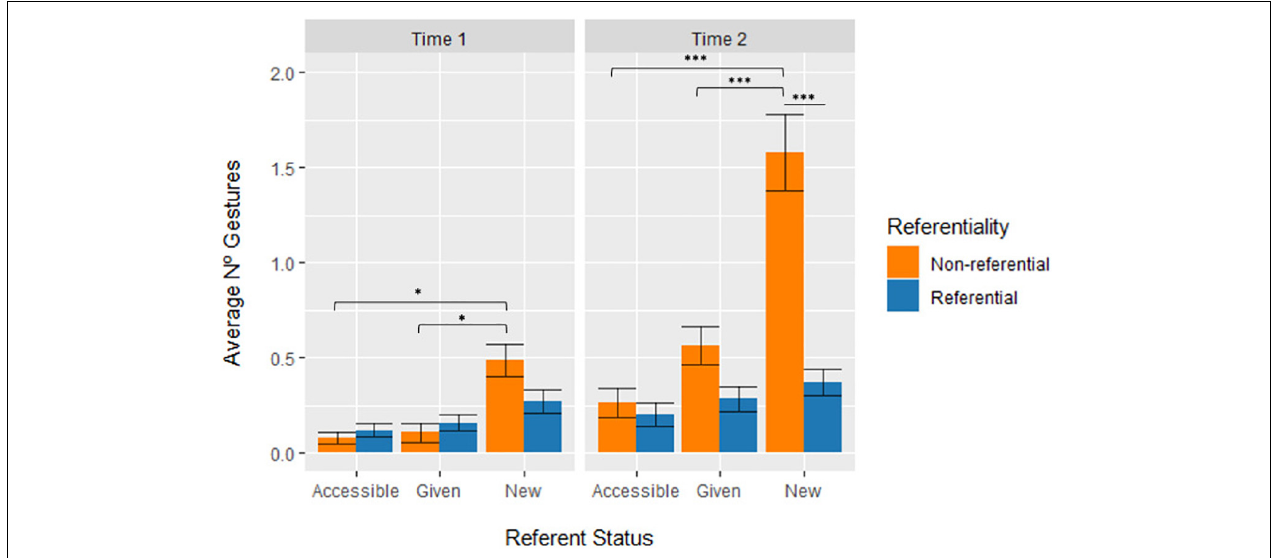
FIGURE 9 | Average number of gestures per child across Time, Gesture Referentiality, and Referent Status. Error bars represent standard error. ∗ stands for p ≤ 0.05; ∗∗ stands for p ≤ 0.01; and ∗∗∗ stands for p ≤